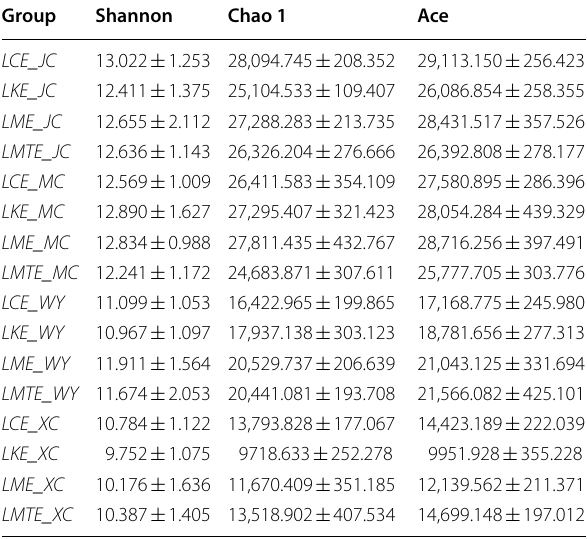
Table 4 Alpha diversity indices Group